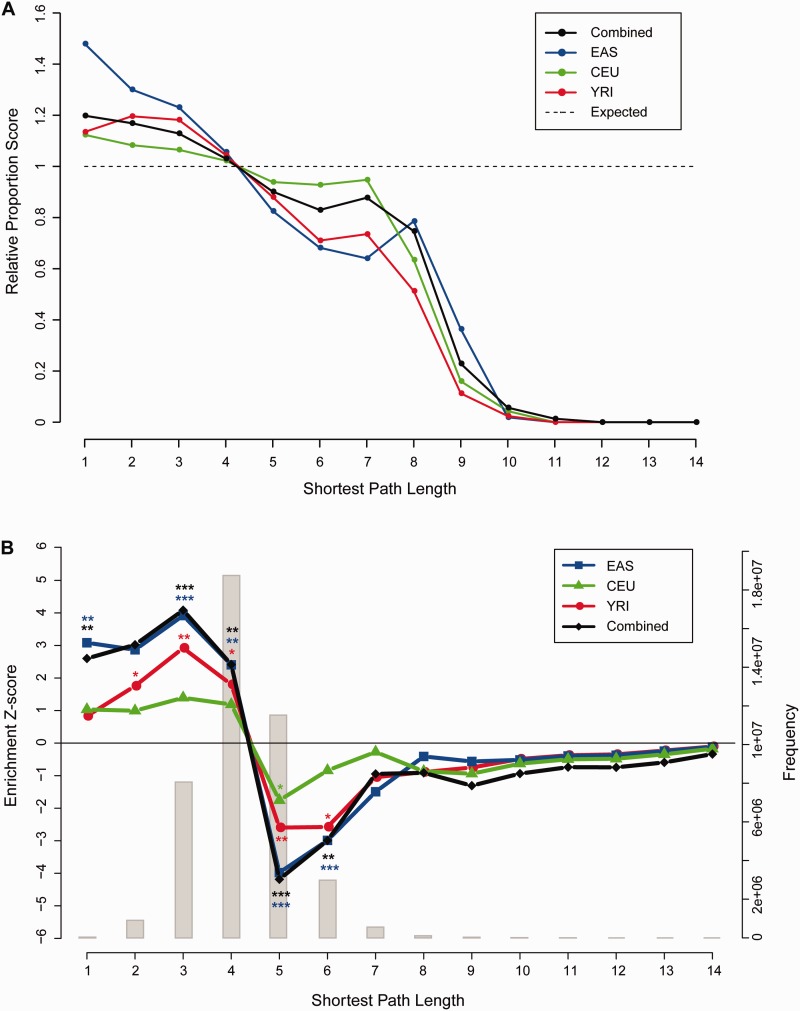
Dependence of signals of recent positive selection on PPI network distances. (A) Proportions of coselected genes over network distance of SPL in CEU, YRI, EAS, and three populations combined and normalized against the expected proportions assuming no coselection (dotted line). (B) The Z-score of coselection (left y axis) is plotted against SPL distances. The frequencies of pairwise interactions of the whole PPI network are plotted against SPL as a background histogram in light gray color. Lines in different colors represent different populations as described in figure 2. * stands for P-values < 0.05, ** < 0.01, and *** < 0.001.